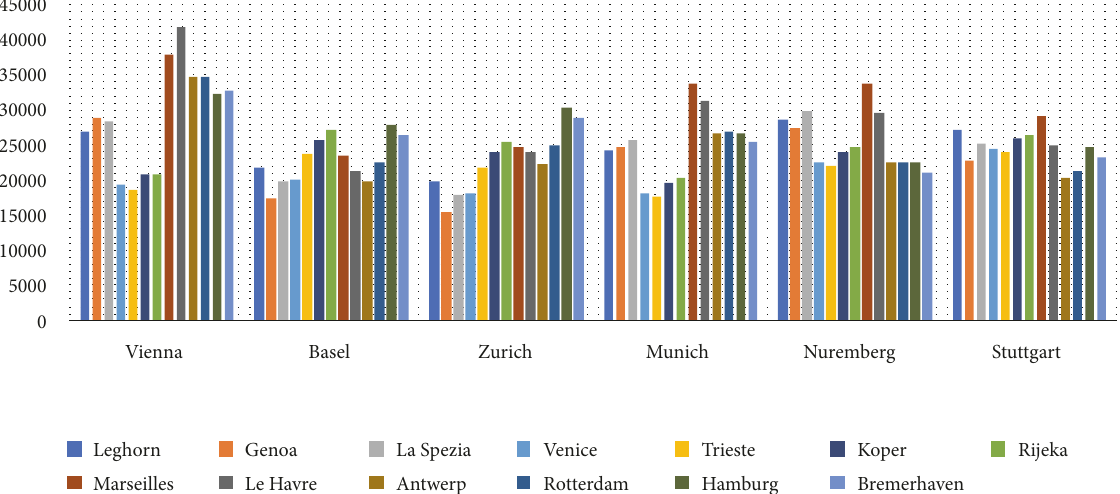
Figure 8: Generalised costs for a full train (€) from the ports considered in the analysis, towards Central-Southern European destinations. Optimisation by generalised